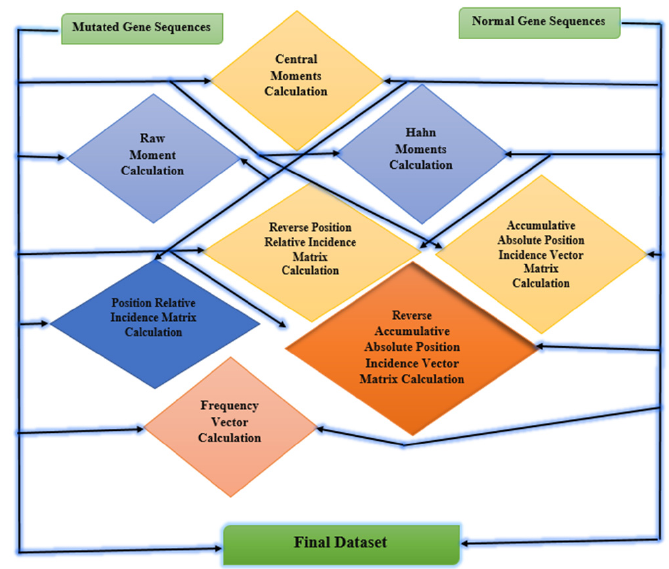
Figure 10. Feature extraction for the breast adenocarcinoma dataset.